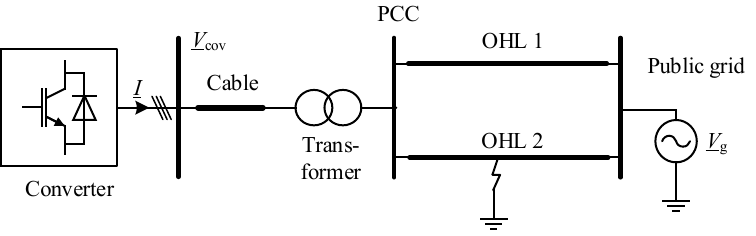
Figure 1. Single-phase equivalent circuit diagram.